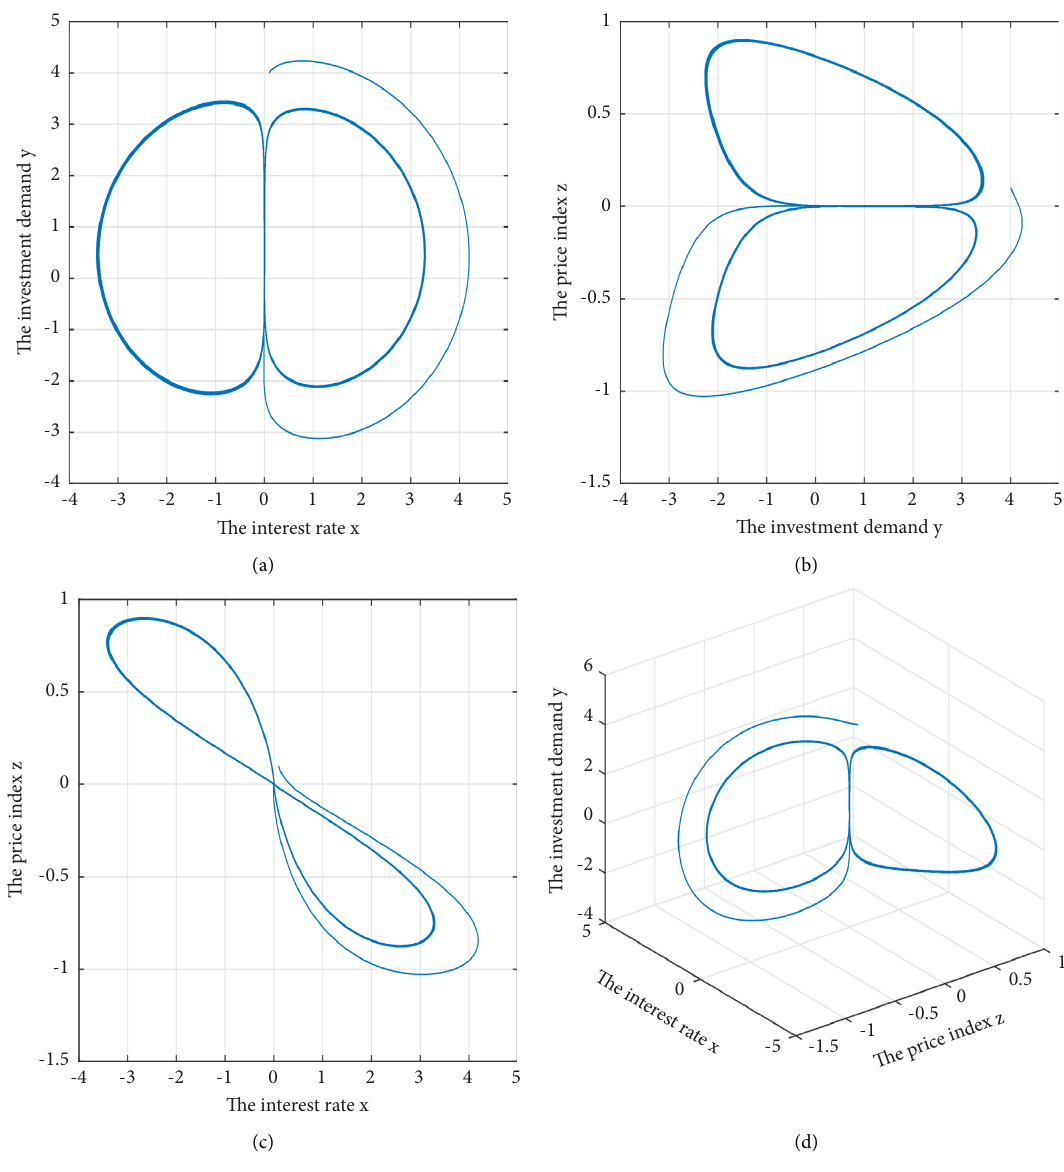
Figure 6: The phase portrait of the proposed model where (a) the demand of investment versus the rate of investment, (b) the index of price versus the demand of investment, (c) the index of price versus the rate of investment, and (d) the chaotic behaviour of the system with a � 0 . 3 ,b � 0 . 01 ,c � 3 . 0, and ϑ � 0 . 8 to identify the influence of these input parameters on the chaos of the